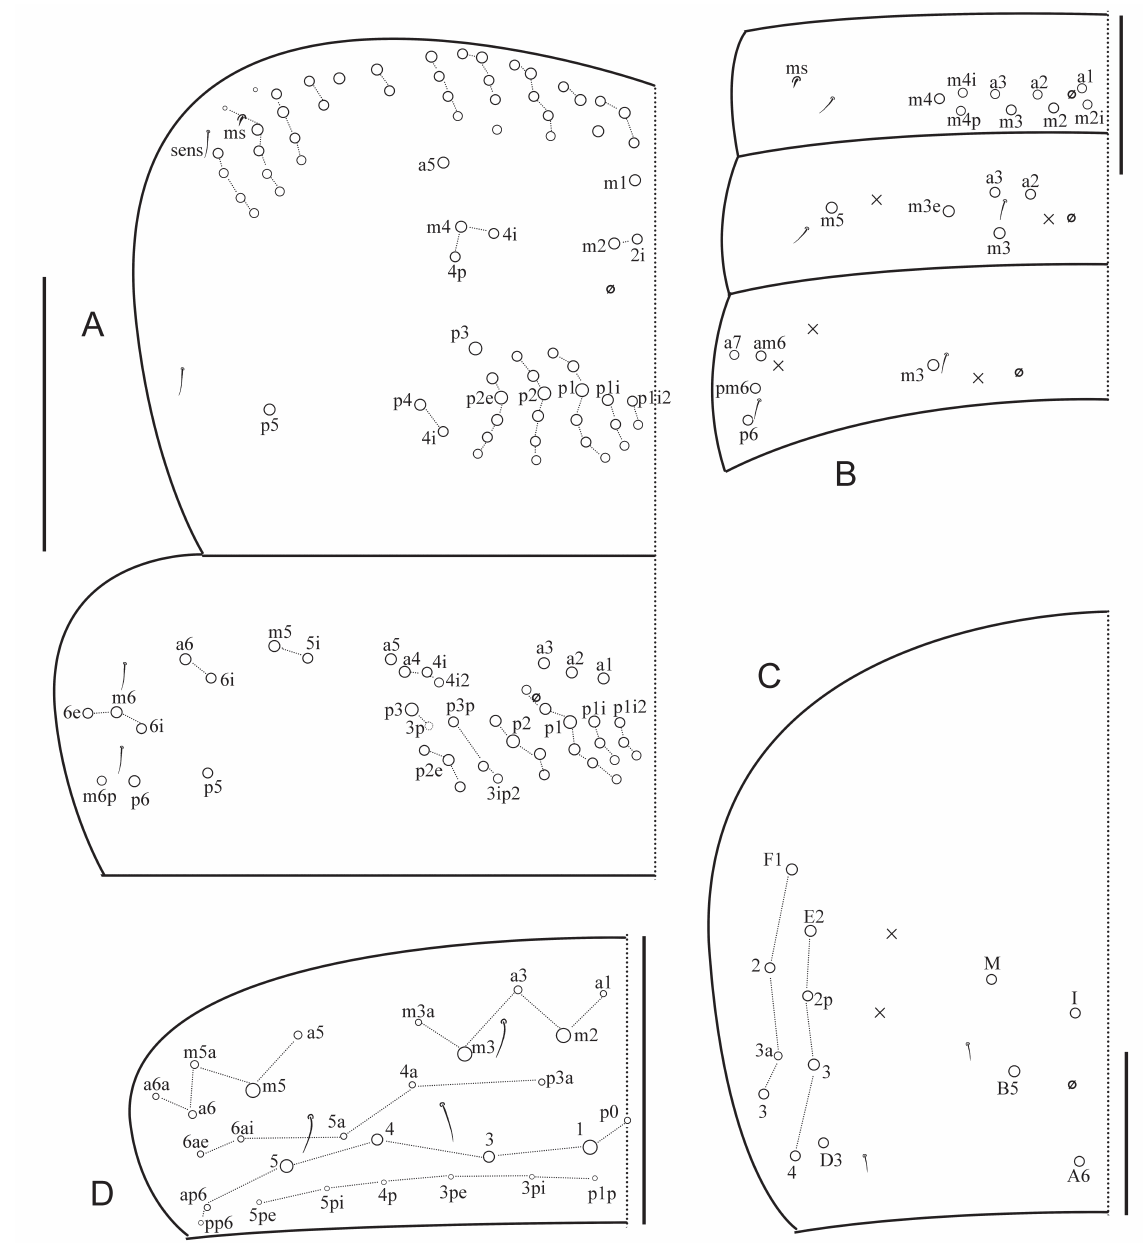
Fig. 3. Coecobrya gejianbangi sp. nov. A . Thoracic chaetotaxy. B – D . Abdominal chaetotaxy. B . Abd. I‒III. C . Abd. IV. D . Abd. V. Scale bars: 200